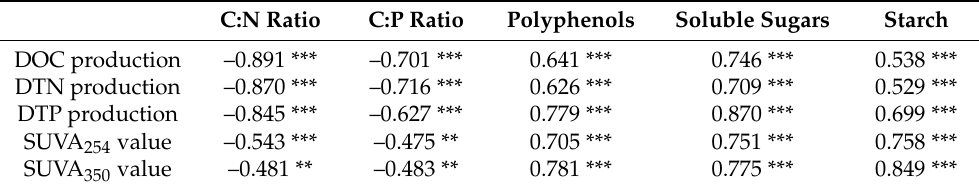
Table A1. Spearman’s correlation coefficients between tree tissue-leached DOM parameters and the initial chemical traits in subtropical plantations in southern